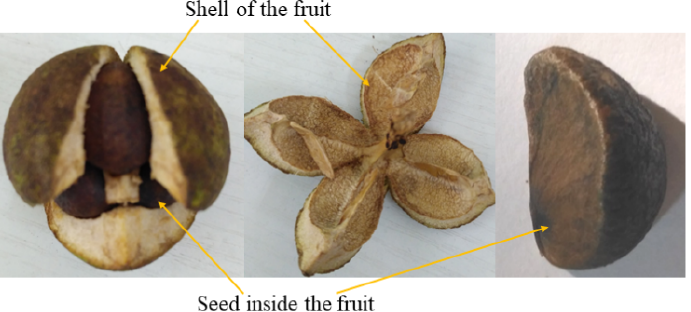
Figure 1. The internal structure of Camellia oleifera fruit.